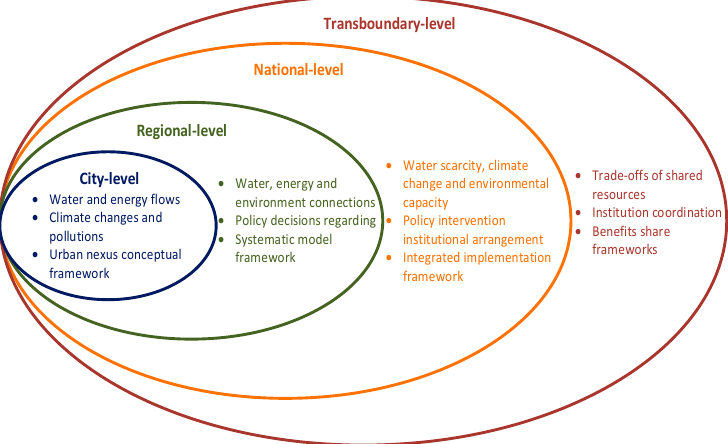
Figure 4. The schematic picture of the research focuses on comprehensive bonding studies at the macro level.